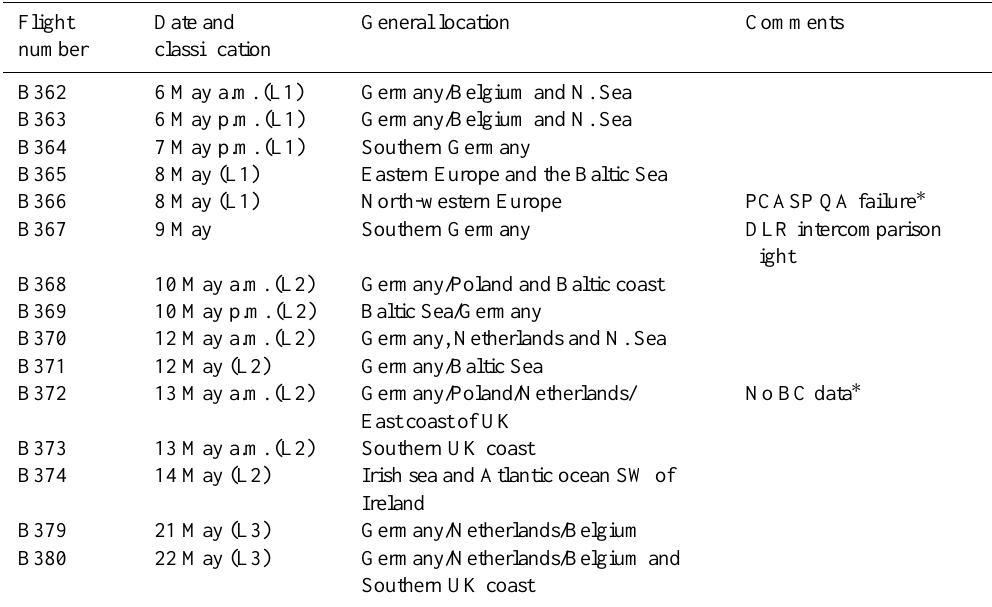
Table 1. Flights from May 2008 used in EUCAARI analysis. Classification according to Morgan et al. (2009): L1 = LONGREX-1, L2 = LONGREX-2, L3 = LONGEX-3. ∗ Not used for closure studies in Sect. 5.